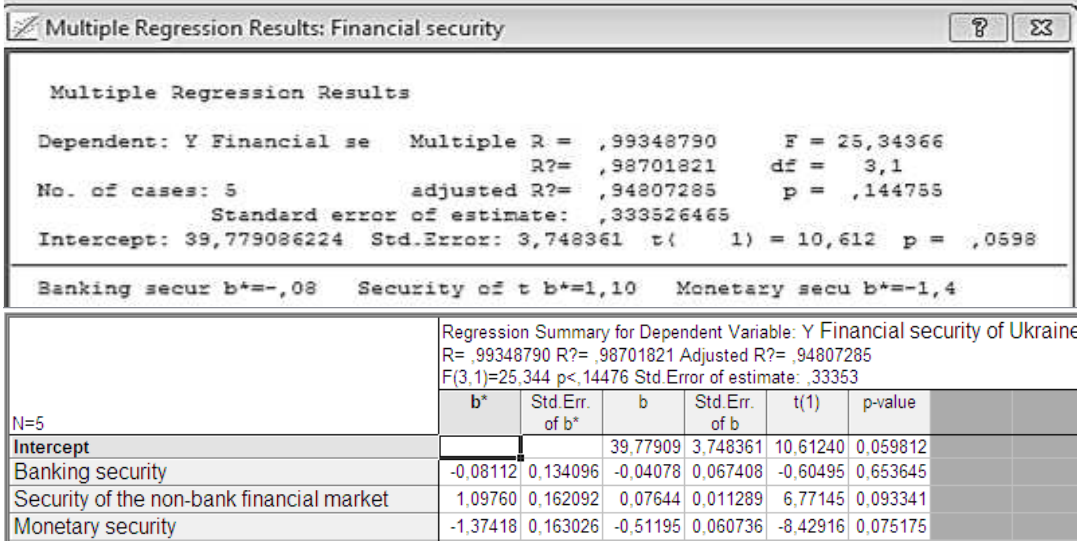
Figure 2. Results of construction of a multiple correlation-regression model of financial security of the